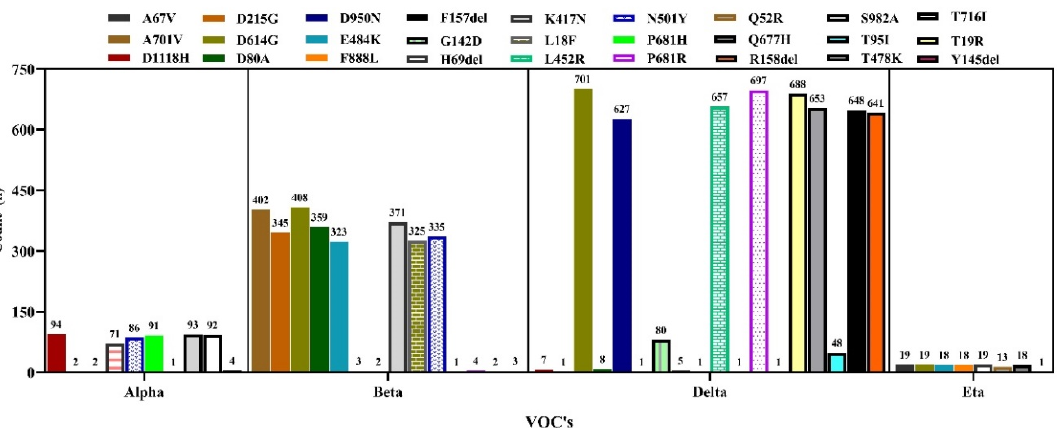
Figure 13. Frequency of substitution mutations in the spike protein of VOCs’ sequences in Bangla- desh.